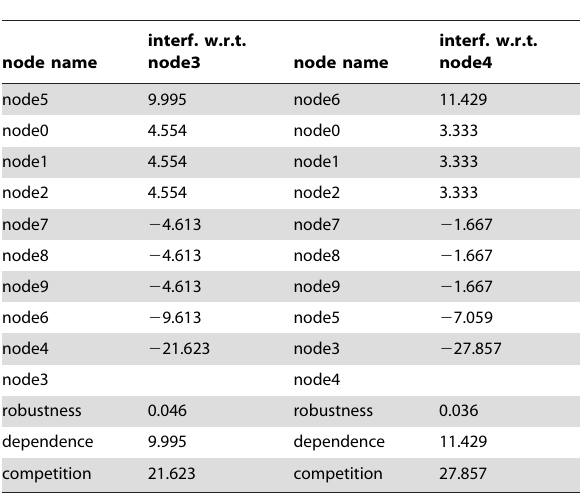
Table 3. The robustness analysis of node3 and node4.